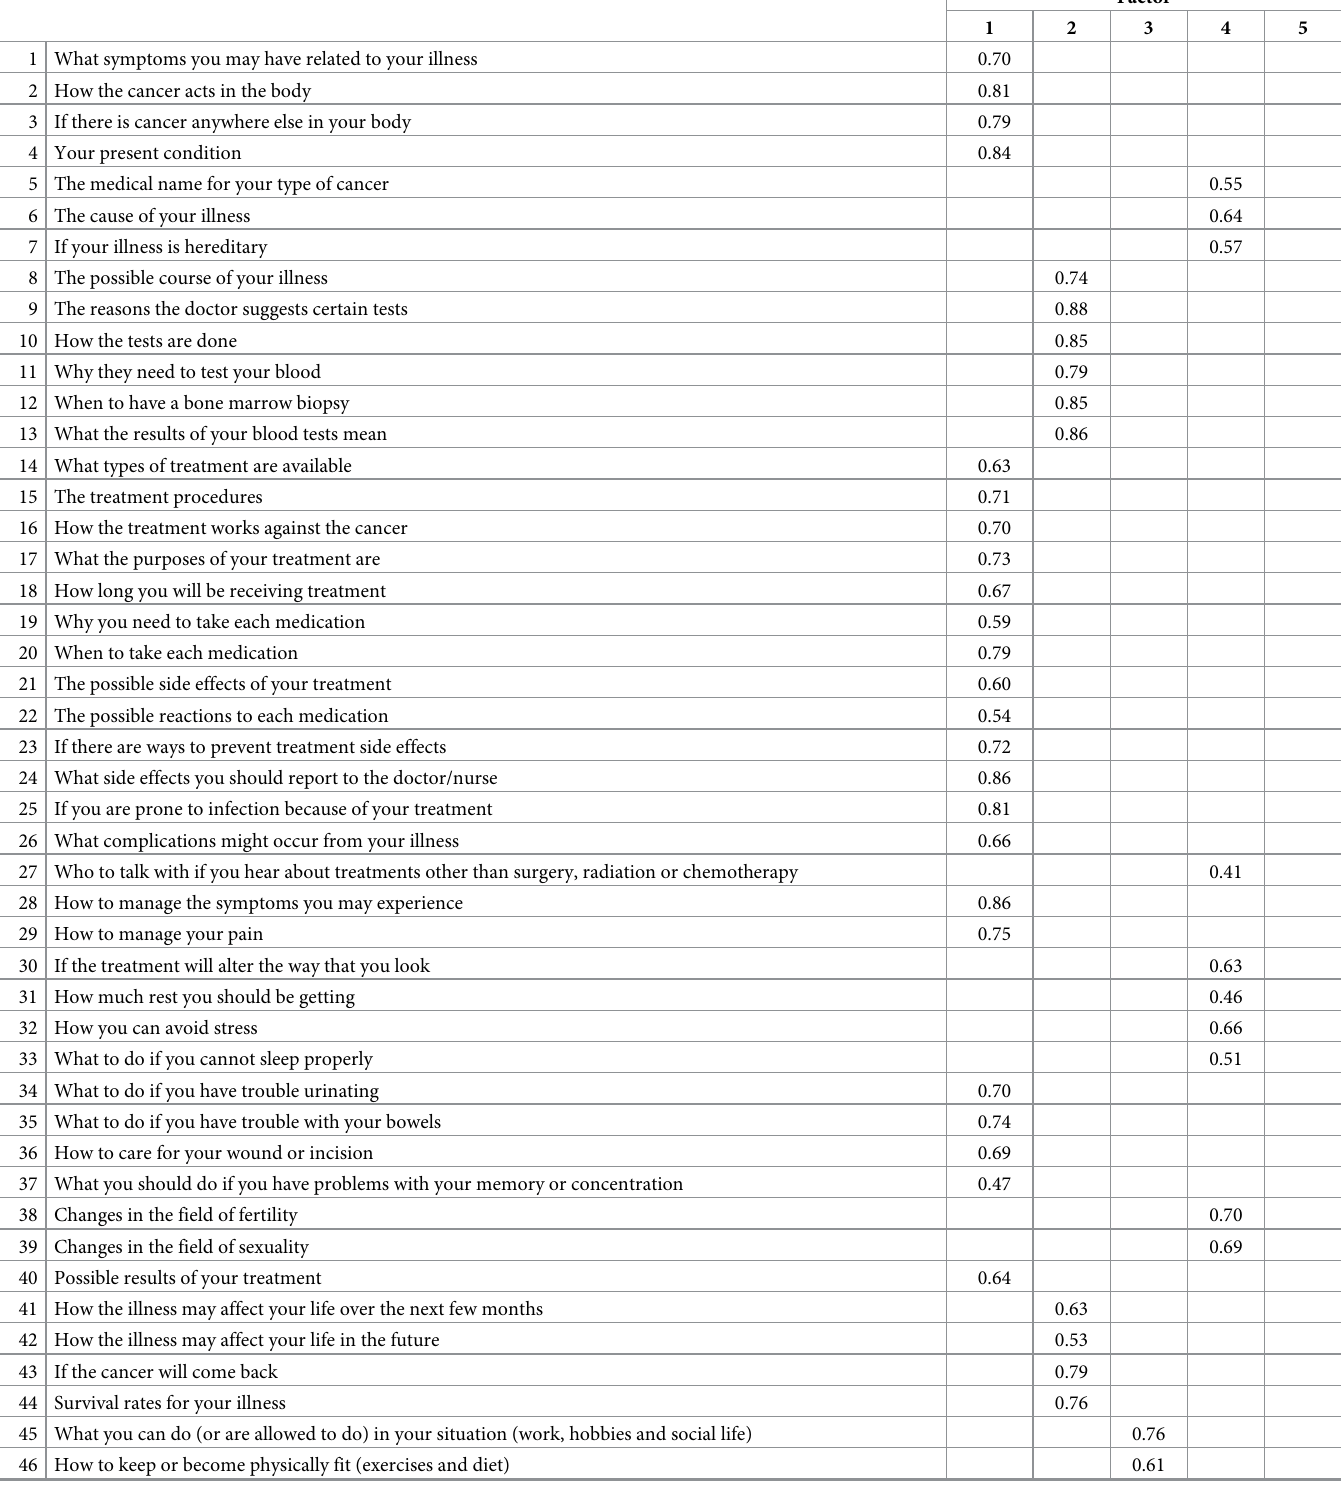
Table 5. Factor loadings of the items on the Hematology Information Needs Questionnaire for study